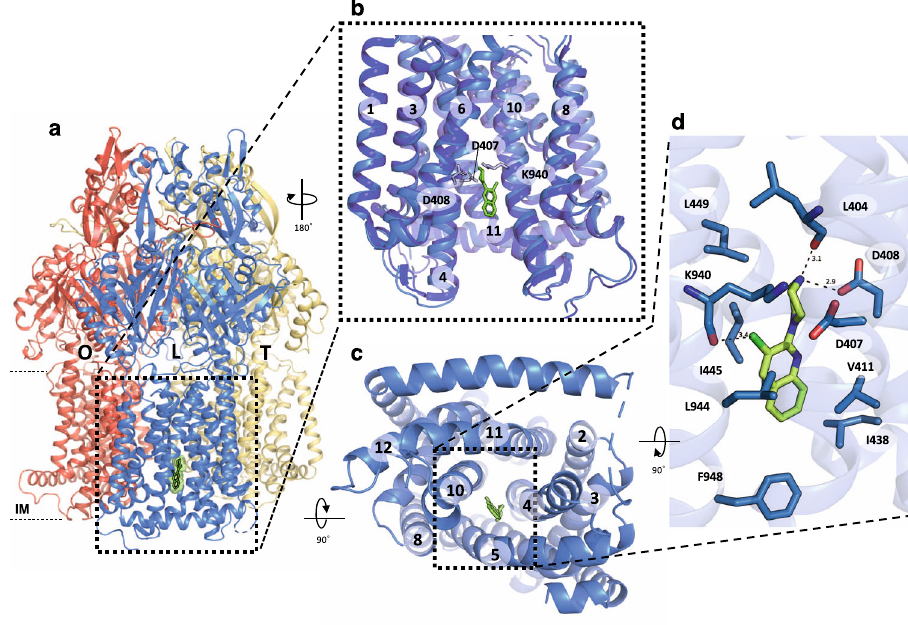
Fig. 2 Structure of AcrB in complex with BDM88855 (9). a Side view of the AcrB trimer comprising the L (marine), T (yellow), and O (red) protomers. BDM88855 (9) (green) binds to the TM domain of the L protomer. The boundaries of the inner membrane (IM) are indicated for the L protomer. b Side view on the TM domain of the L protomer. The apo-structure (dark blue) and the BDM88855 ( 9 )-bound L protomers (marine) are superimposed and indicate subtle shifts in helix movements to accommodate the pyridylpiperazine inhibitor. The inward-open TM domain of the AcrB L protomer indicates the binding of BDM88855 ( 9 ) (green, stick representation) near the proton relay triad D407, D408, and K940. c Cytoplasmic side view into the TM domain of the AcrB L protomer (marine) and the location of BDM88855 ( 9 ) (green, stick representation) nested between TM helices 4, 5, and 10. d Enlarged view of the inhibitor binding site showing interacting residues (marine sticks) in less or equal than 4 Å distance from BDM88855 ( 9 ). The salt bridge between the piperazine ring and D408, the halogen bond between the BDM88855 ( 9 ) chlorine and the K940 main chain carbonyl oxygen, and the hydrogen-bond between the L404 main chain carbonyl oxygen and the piperazine ring are indicated by dashed lines and numbers represent the distance in